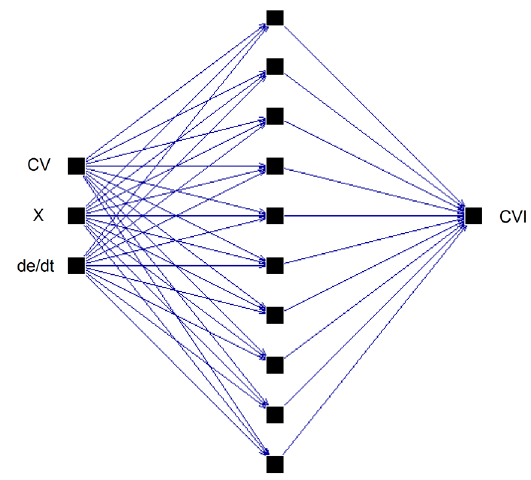
Figure 11. The structure of the neural network controller NN.